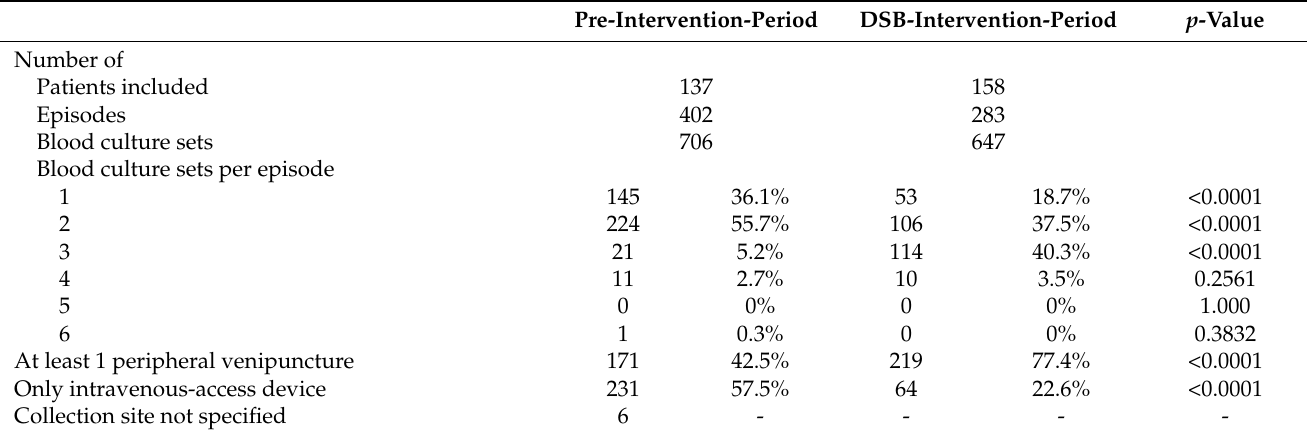
Table 1. Quality parameters of the pre-intervention and the post-intervention study period; DSB: diagnostic stewardship